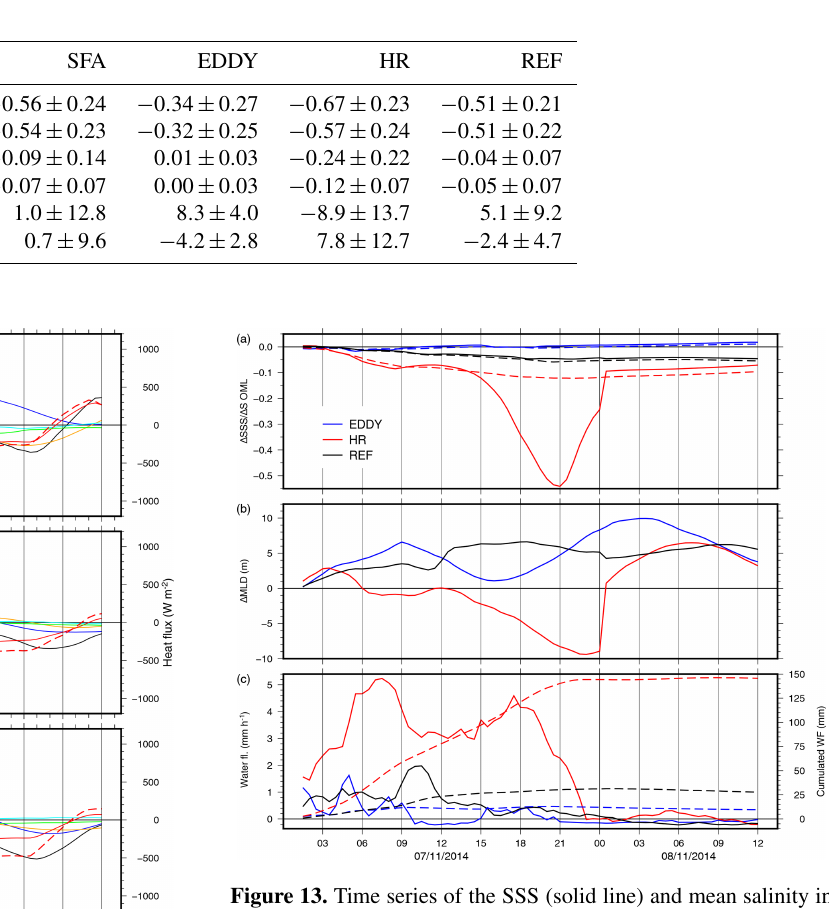
Table 2. Evolution of oceanic parameters between the beginning of the simulation (04:00UTC on 7 November) and 00:00UTC on 8 Novem- ber in the different zones (see text).